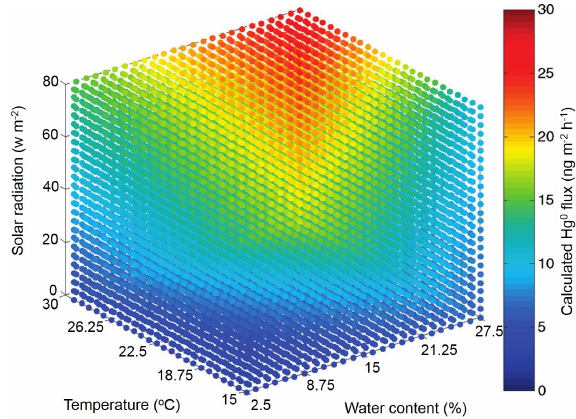
Figure 4. 4-D graphical visualization of the synergetic effect of air temperature, soil water content and solar radiation on the measured Hg 0 flux from soil (Lin et al.,